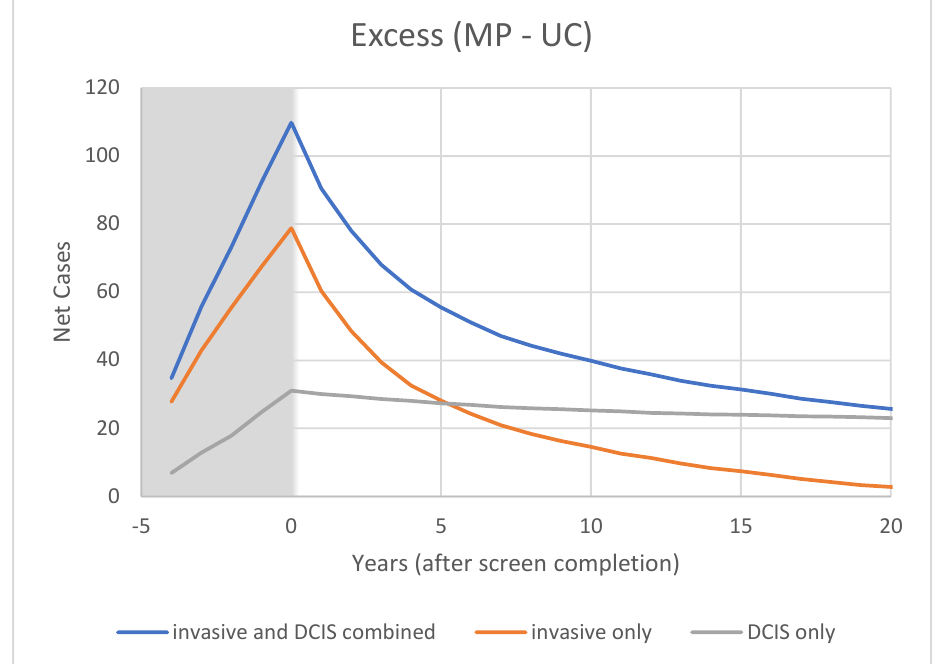
Figure 5. Modeled cumulative excess breast cancer detection in CNBSS1 from OncoSim-Breast. Shaded area represents screening